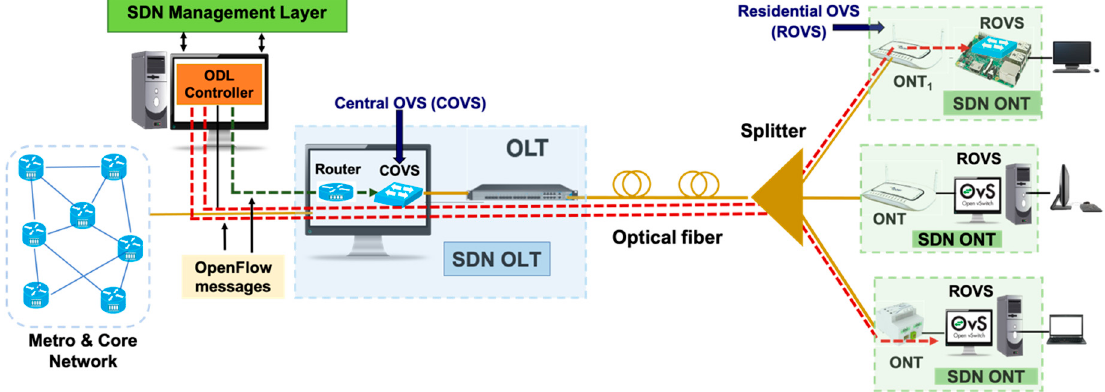
Figure 1. The software defined networking (SDN)-OpenFlow scenario implemented in the gigabit passive optical networks (GPONs) testbed.